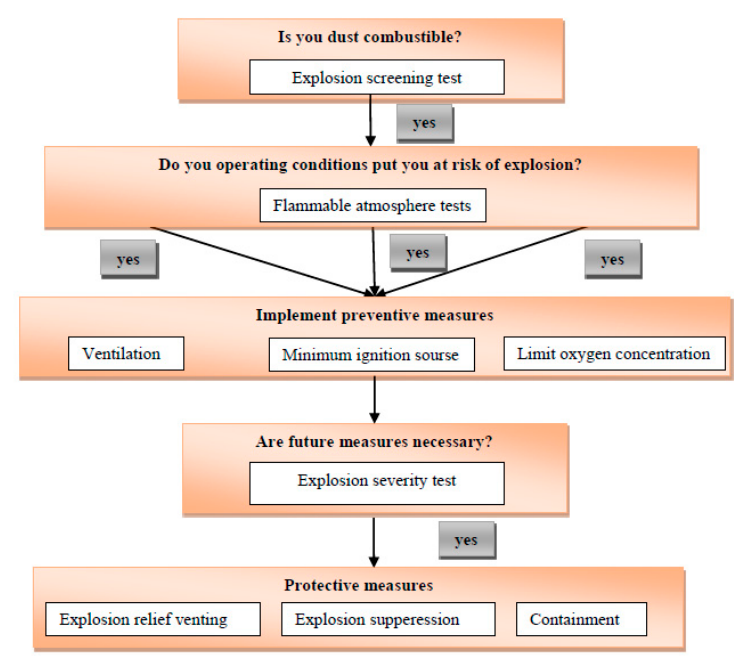
Figure 1. Procedure for applying preventive measures [22].